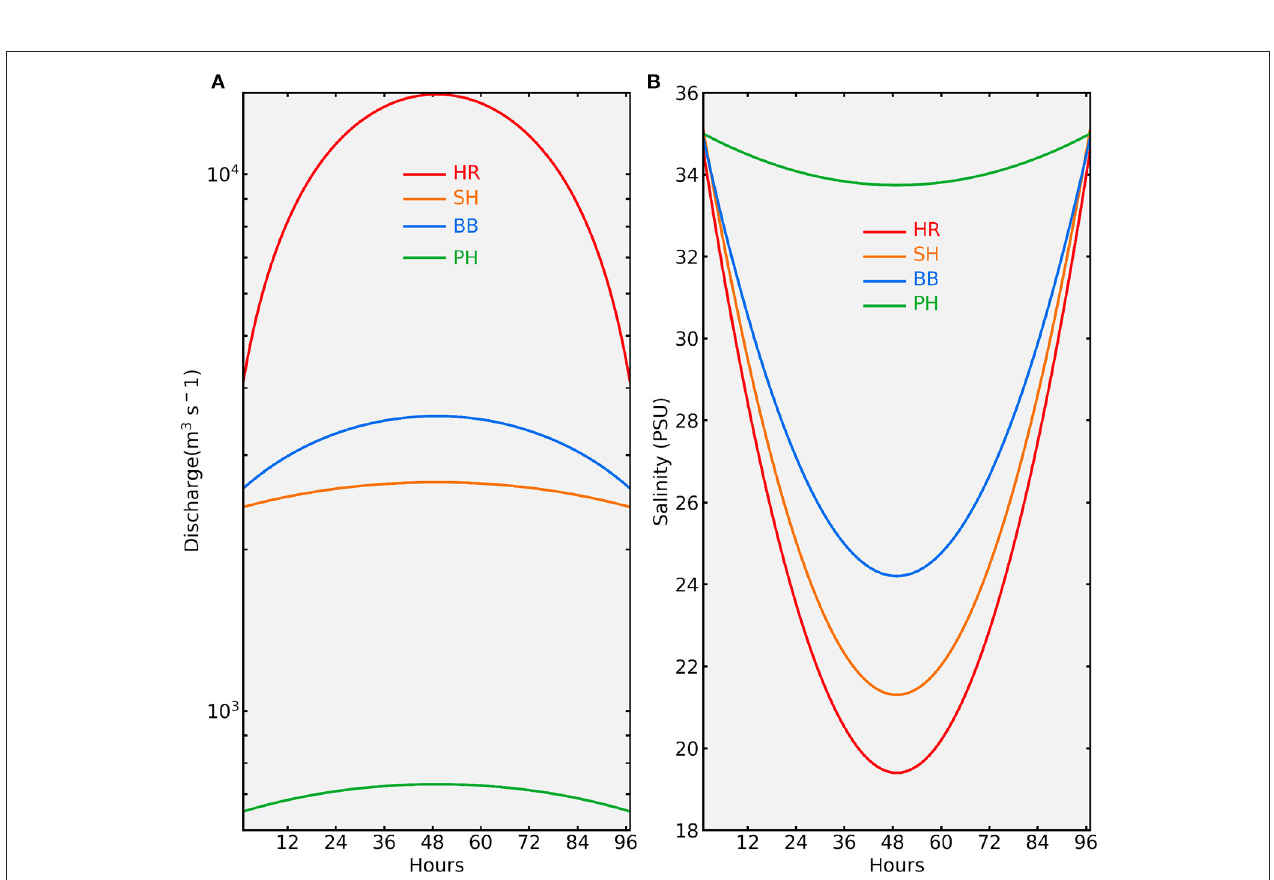
FIGURE 3 | River discharges and salinity at the river mouths during the wet event scenarios. (A) Time series of river discharges during the wet event, the discharges return to the same constant value as base case 96 h later. Discharges of HR, SH, BB, and PH rivers are indicated with red, orange, blue, green, and black lines, respectively. (B) Same as (A) , but for the salinity.